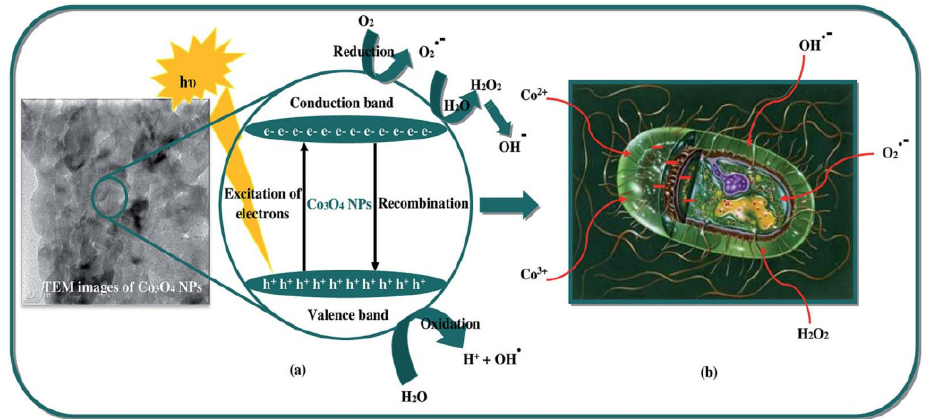
Figure 6. Graphic representation showing the antibacterial mechanisms of cobalt oxide nanoparticles: ( a ) formation of OH after light irradiation of nanoparticles. ( b ) Inhibition of bacterial growth after exposure to nanoparticles. Reproduced from Sivachidambaram et al. [76] with permission from the Royal Society of Chemistry under the open access Creative Common CC BY license of RSC Advances.